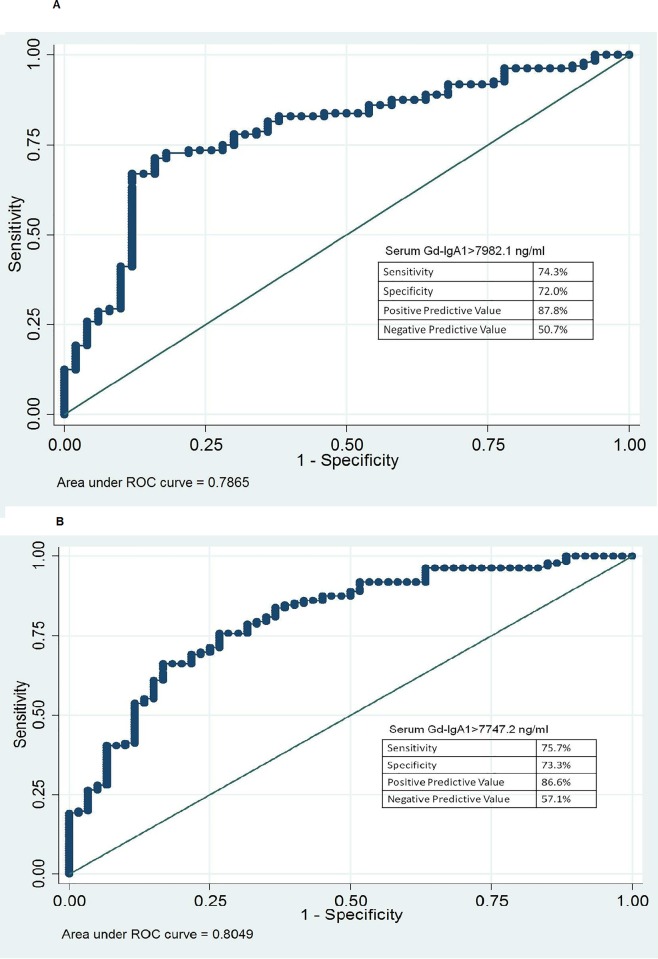
A ROC curve of serum galactose deficient IgA1 level against IgA nephropathy patients and healthy controls 2B ROC cure of serum galactose deficienty IgA1 level against IgA nephropathy patients and non-IgA glomerular disease controls.